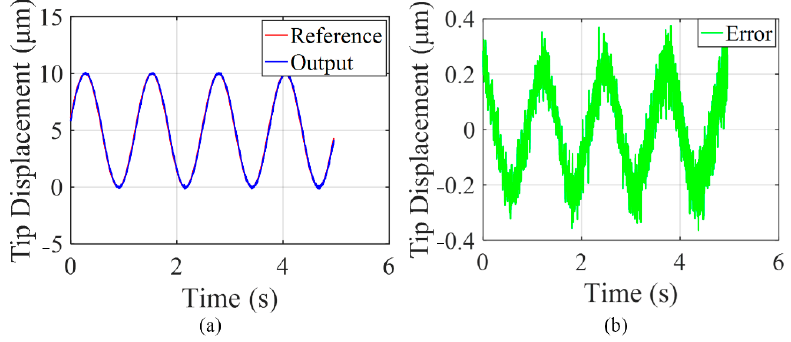
Figure 9. Position tracking experimental results of the microgripper: ( a ) the tracking trajectory, ( b ) the position tracking error.